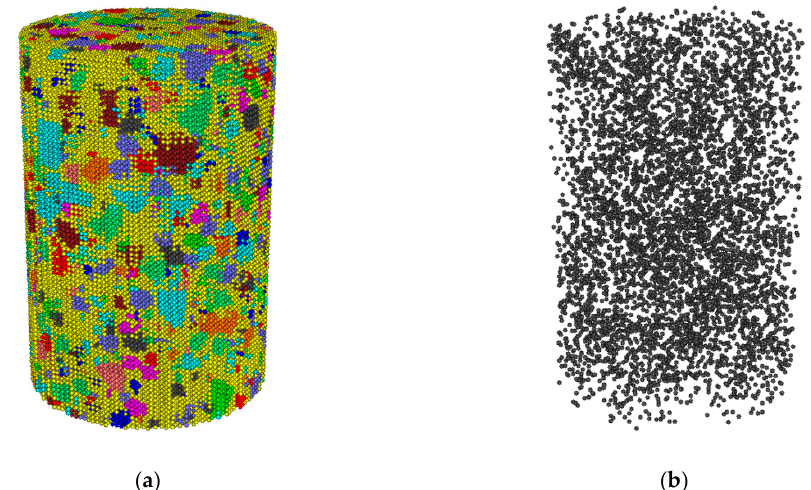
Figure 5. ( a ) Discrete element (DE) model of asphalt mixture; ( b ) air voids within the DE model.